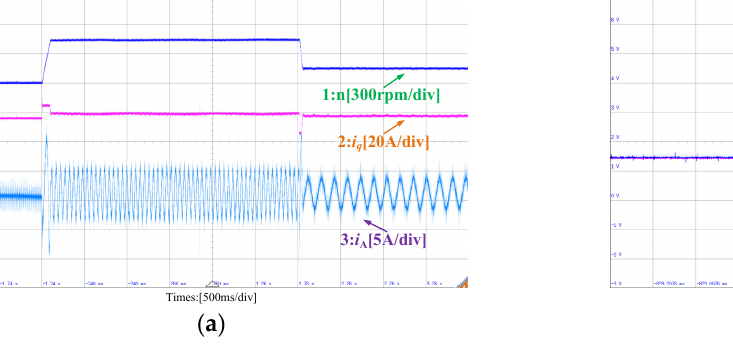
Figure 13. Dynamic Performance Evaluation: ( a ) acceleration and deceleration at 500 r / min with 2 N / m ( 1:n [300 rpm/div], 2:𝑖 (cid:3044) [20 A/div], 3:𝑖 (cid:2885) [5 A/div]); ( b ) current loop following performance ( 1: 𝑖 (cid:3044)∗ [10 A/div], 2: 𝑖 (cid:3044) [10 A/div]).